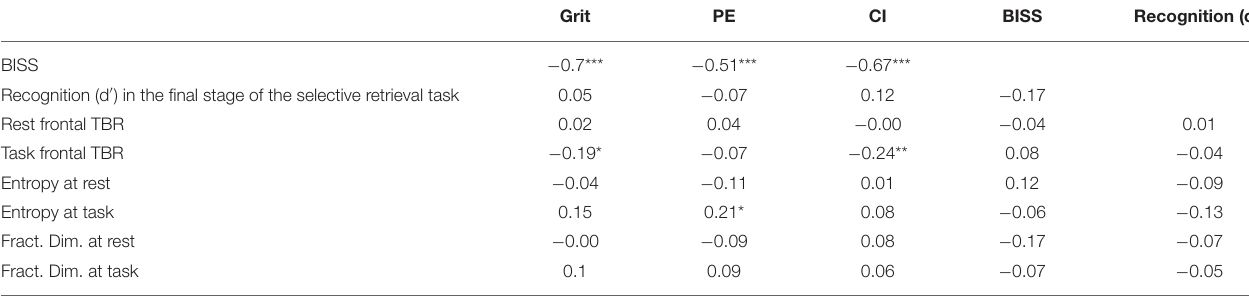
TABLE 7 | Pearson correlations of the main brain variables, the Grit and BISS scores and performance in the task. Grit PE CI BISS Recognition (d ′ ) BISS − 0.7*** −